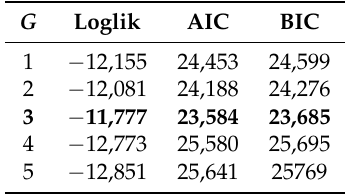
Table 2. Model selection. Ordinal variables